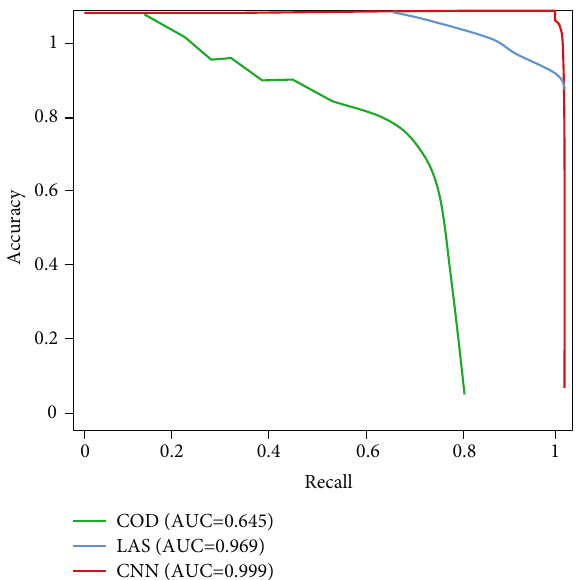
Figure 8: PR curve of the recognition method on the dataset (CNN changed to SSD-MobileNet).